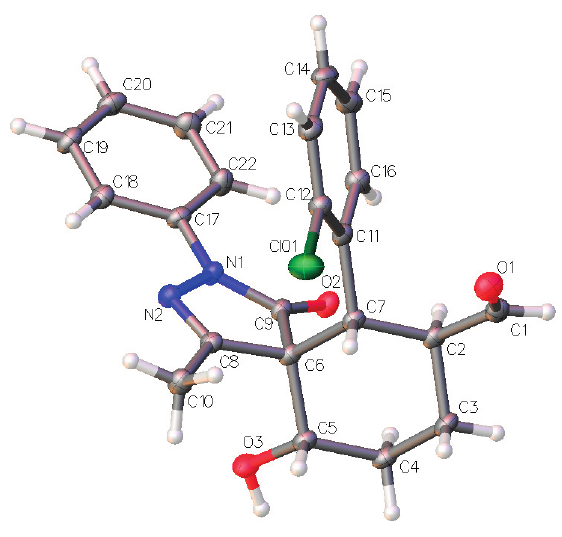
Figure 5. X-ray structure of compound 3d (major diastereomer). The displacement ellipsoids are drawn at the 50% probability level